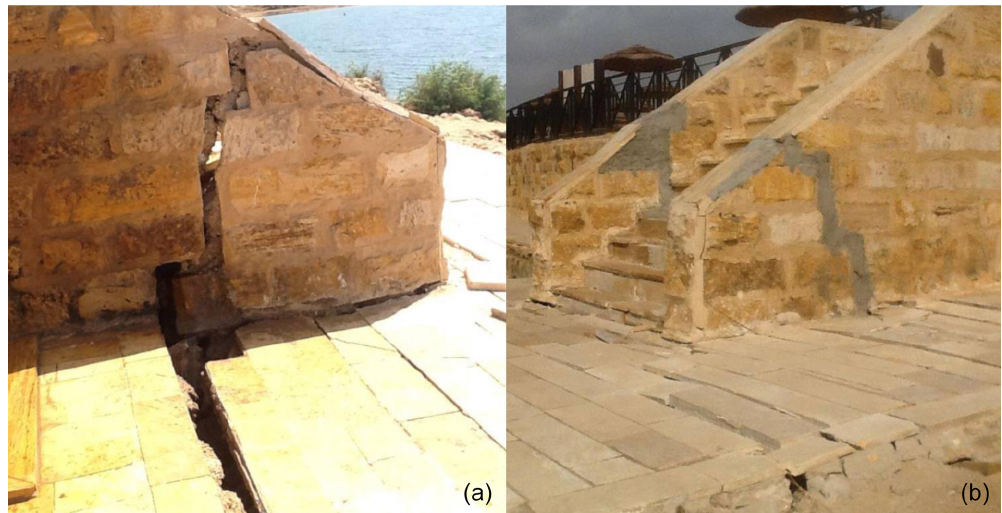
Figure 8. Examples of damage (a) and of quick repair (b) that are common at the beachfront of the hotels along the DS coastline.